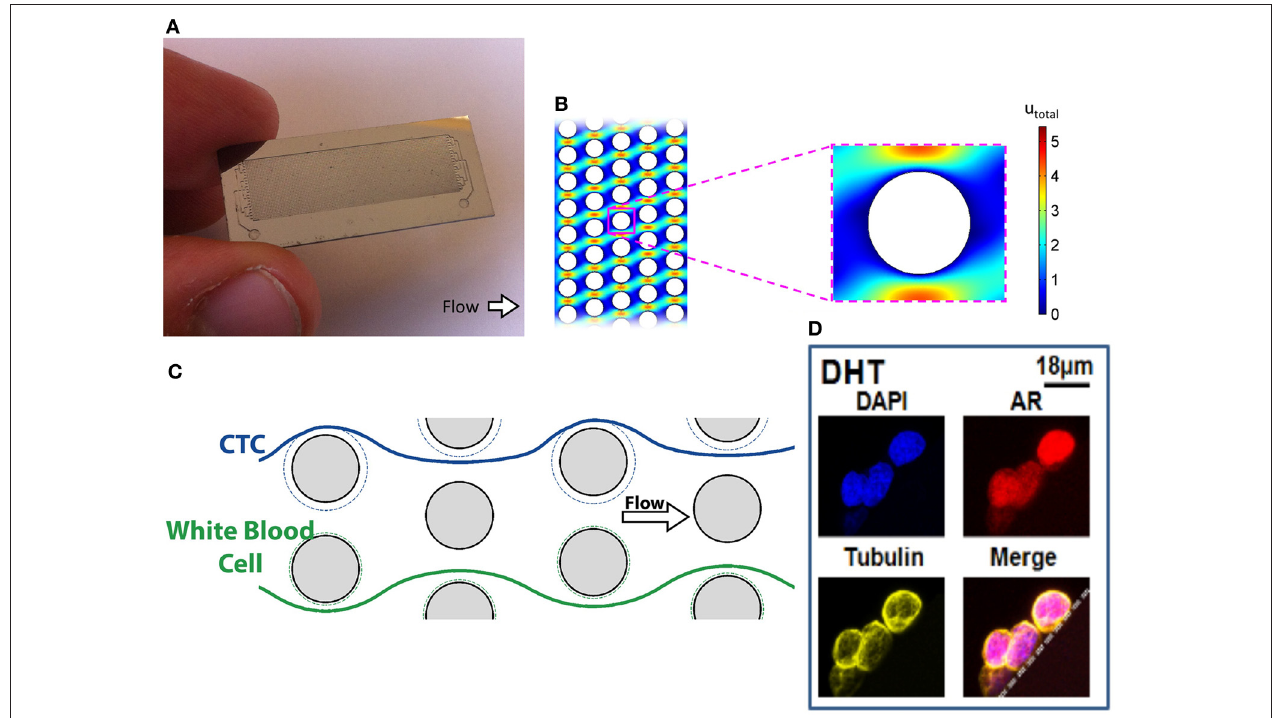
FIGURE 2 | Geometrically-enhanced differential immunocapture (GEDI) microfluidic device. (A) GEDI Chip (B) GEDI post-array (C) Illustration of laminar flow through GEDI device (D) Captured CTCs stained for AR and